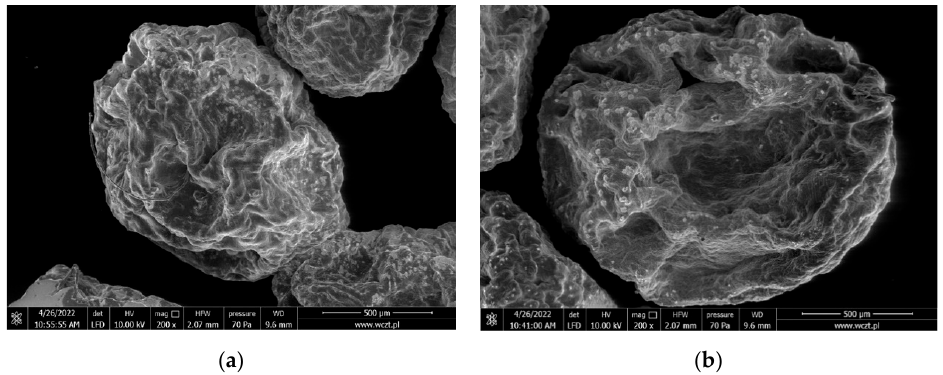
Figure 7. Comparison of scanning electron micrographs of alginate capsules with different gemini surfactants: ( a ) Al@12-O-12; ( b ) Al@10(E)-3-10(E) Cl. In order to confirm the encapsulation, FTIR spectra (ATR technic) were made after the capsules were thoroughly washed with water and dried. In Figure 8a , there is a spectrum of empty alginate capsules (Al@empty). The most intense band in the spectrum at 3347 cm − 1 comes from the O-H stretching vibrations of the O-H hydroxyl group. The broadening of the band indicates the presence of hydrogen bonds. Another characteristic band at 1598 cm − 1 is derived from the carbonyl group of the carboxylate. Remaining spectra derived from capsules filled with gemini surfactants prove the correct encapsu- lation path. In Figure 8b, there is a spectrum of alginate capsules with gemini surfactant 12-O-12 (Al@12-O-12) and in addition to the characteristic bands of alginate, bands de- rived from gemini surfactant can be seen, especially the bands coming from the C-H stretching vibrations of the methylene and methyl groups at 2854 cm − 1 and 2922 cm − 1 . The last spectrum from capsules filled with gemini surfactant with ester groups (Al@10(E)-O-10(E) Cl) looks analogous, which has an additional band derived from ester carbonyl at 1748 cm − 1 .